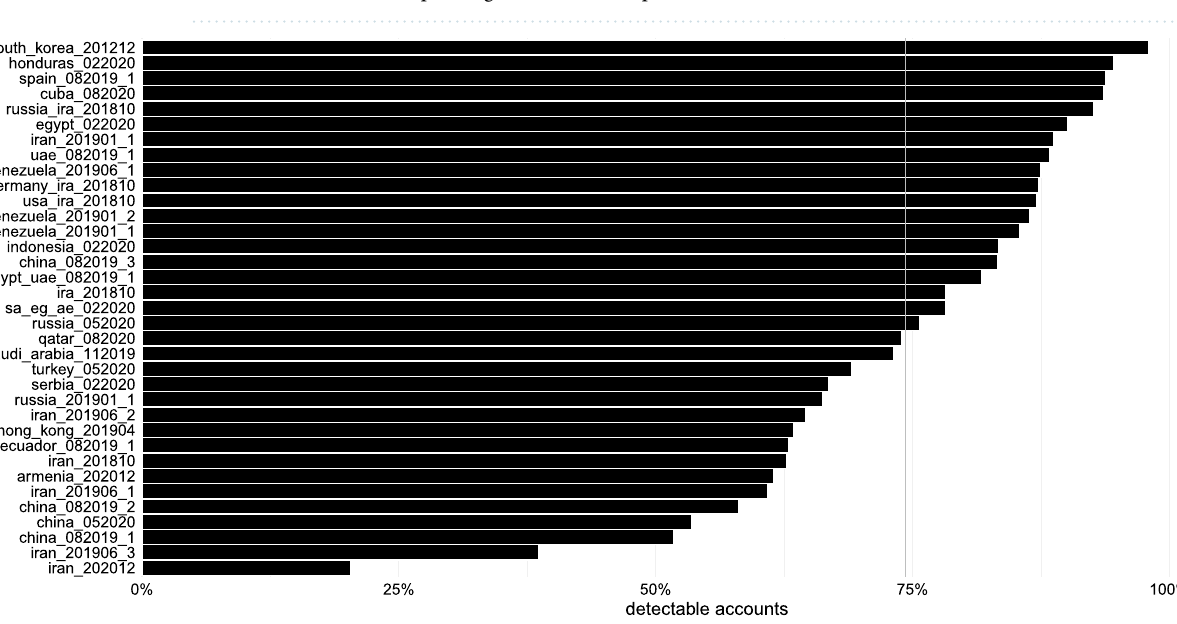
Figure 5. Astoturfing accounts are much more likely to coordinate their activity than comparison users for any given threshold. Astroturfing accounts (red) and comparison user accounts (black) classified as astroturfing accounts, location-based (top row) and hashtag-based (bottom row). Based on appearance in either the co-tweet or co-retweet network, depending on different temporal thresholds.